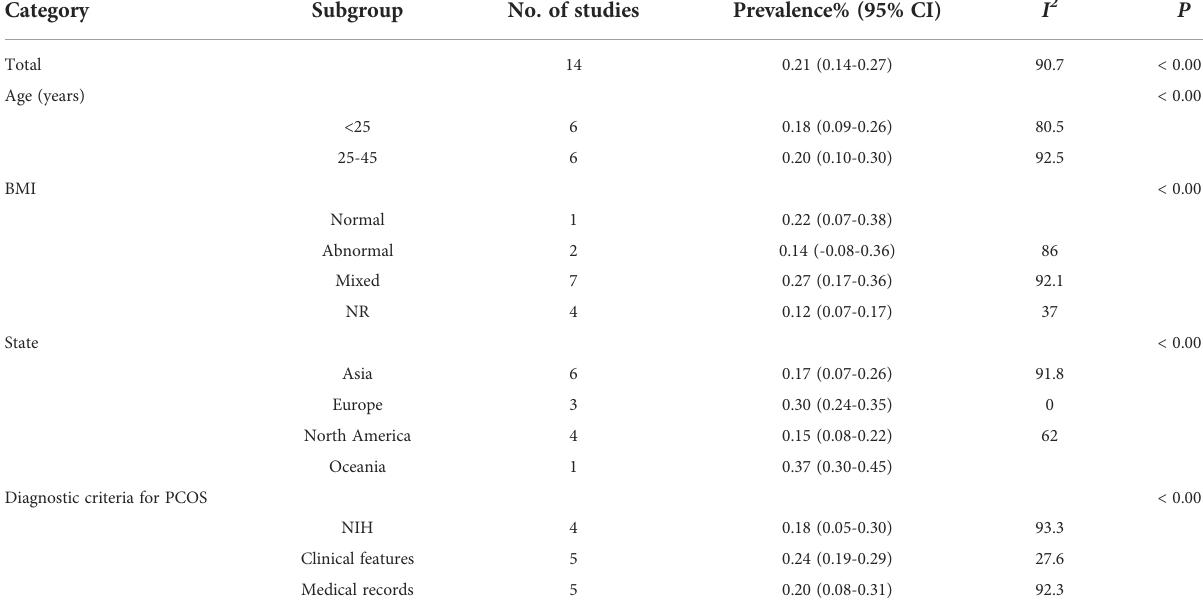
TABLE 2 Prevalence of including studies as per study and design characteristics.